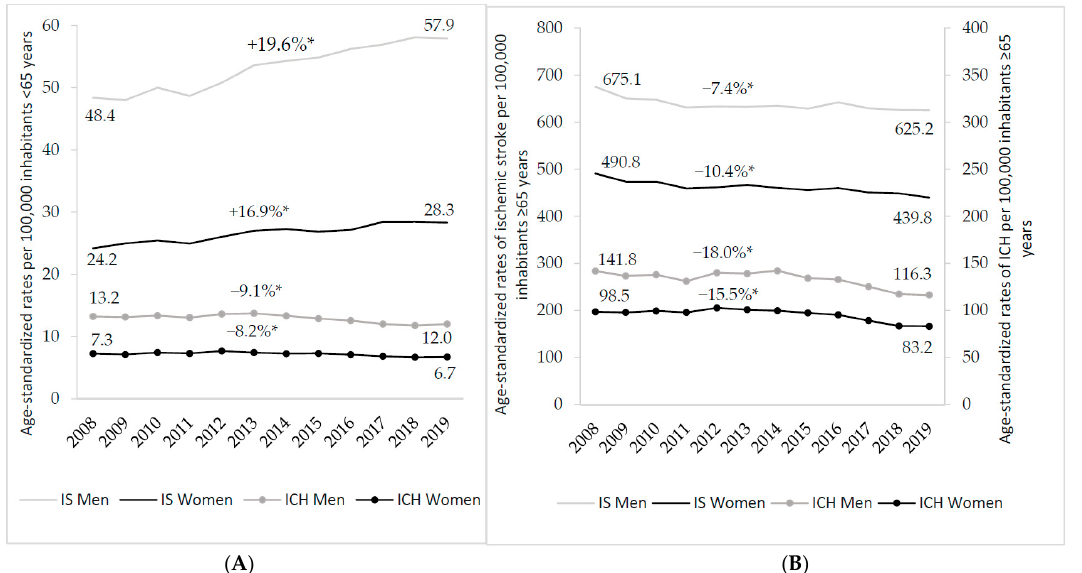
Figure 1. Time trends in age-standardized † rates of patients hospitalized for ischemic stroke (IS) and intracerebral hemorrhage (ICH) between 2008 and 2019 in France according to sex and age group. ( A ) Among inhabitants under 65 years. ( B ) Among inhabitants over 65 years. Gray: men; black: women. * p -value for trend < 0.05. † Rates standardized on the age structure of the 2010 European population census.